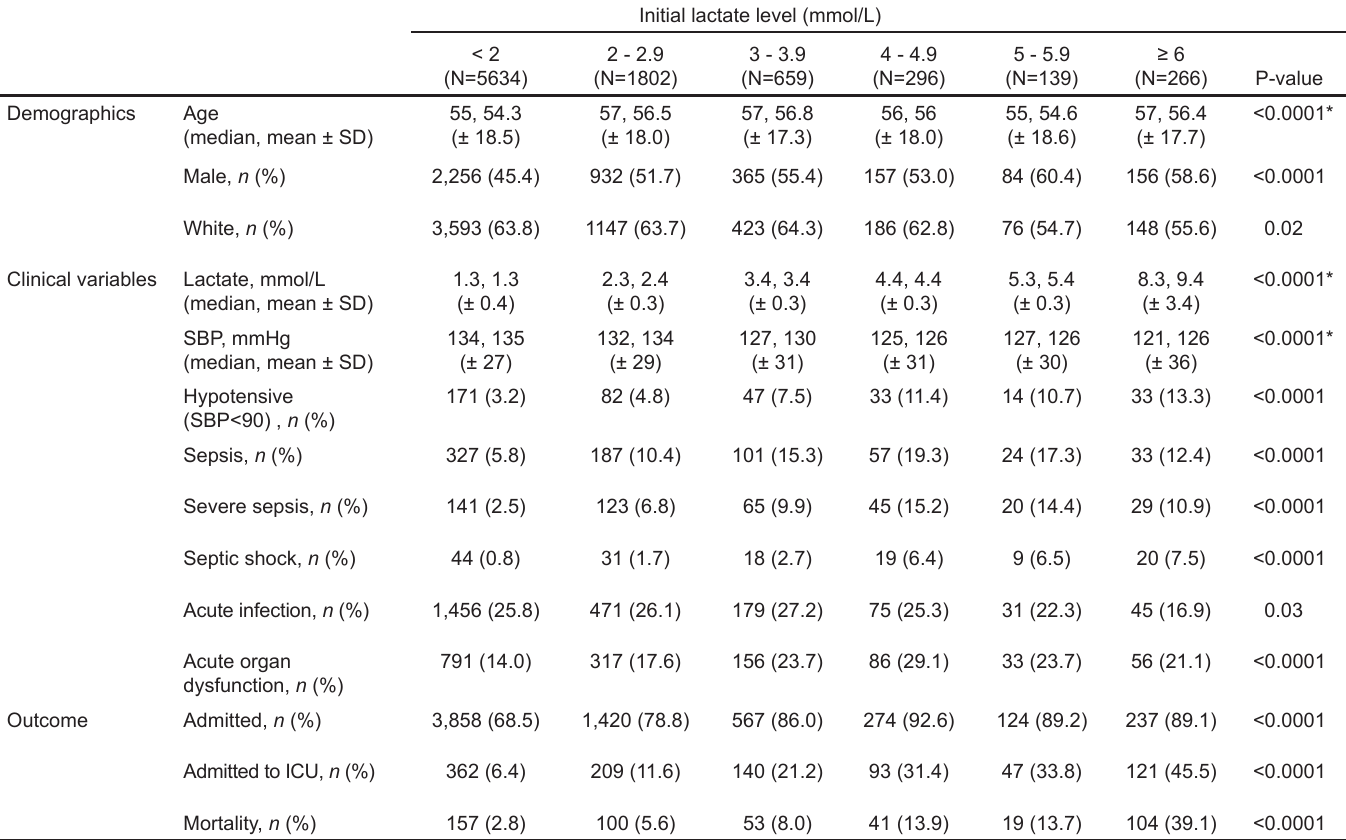
Table 1. Population characteristics by lactate levels.